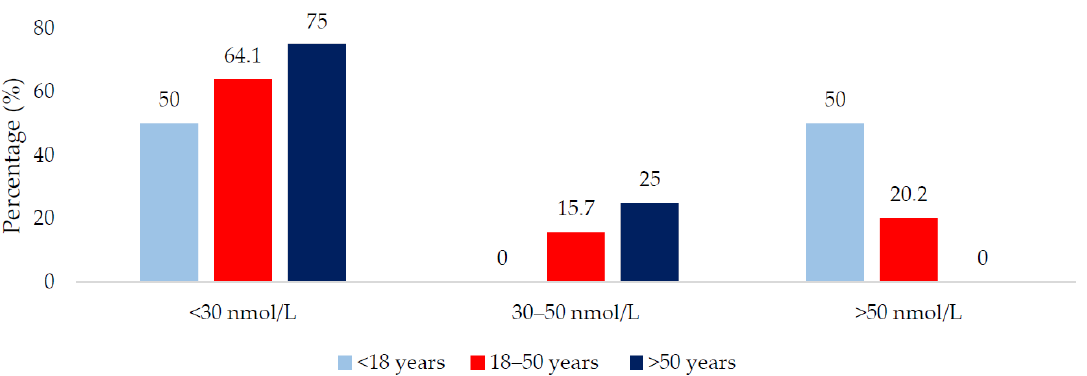
Figure 3. Vitamin D status of the population during the low vitamin D synthesis period (October to March) sub-divided by age group.